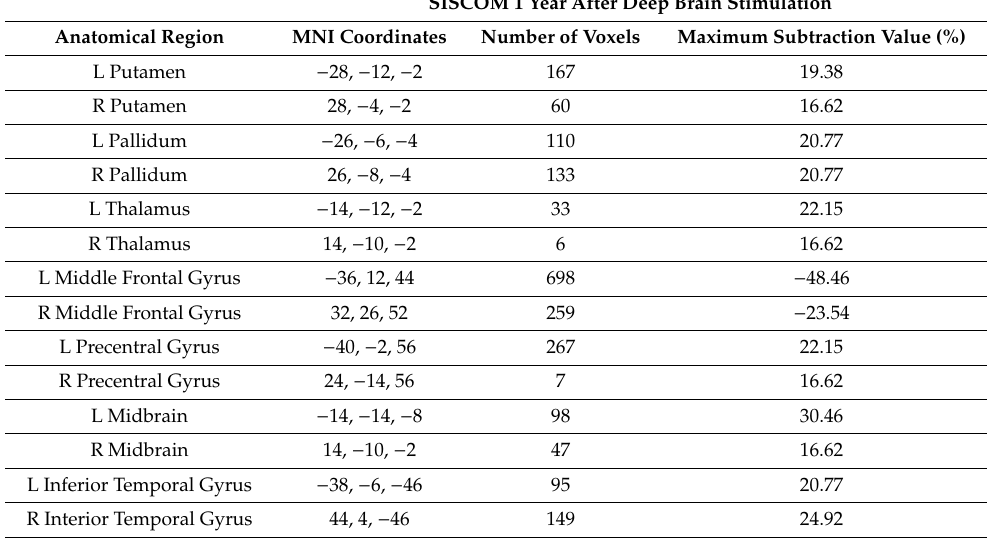
Figure 6. PET / MRI co-registration and voxel-based subtraction analysis of one year after deep brain stimulation (DBS) from pre-operation. Red scale indicates an increase in glucose metabolism and blue scale indicates a decrease in glucose metabolism. ( A ) A noticeable decrease in glucose metabolism in the dorsolateral prefrontal cortex (DLPFC) (asterisk) and an increase in glucose metabolism in the ventrolateral thalamus, globus pallidum internus (Gpi), globus pallidum externus (Gpe) and putamen (arrowhead). ( B ) A noticeable decrease in glucose metabolism was observed in the DLPFC, especially in the left hemisphere and an increase in glucose metabolism was identified in the medulla, pons, midbrain, cerebellar lobules, inferior temporal lobe, ventrolateral thalamus, Gpi, Gpe, putamen, and premotor cortex bilaterally on PET / MRI images obtained one year after DBS and compared with preoperative PET / MRI. Table 1. The values given are the stereotactic MNI coordinates and the peak value of each anatomical region. The threshold was set at 2 standard deviations of SISCOM results. (Voxel size: [2.0, 2.0, 2.0] mm, Minimum cluster size threshold of 50 voxels.).